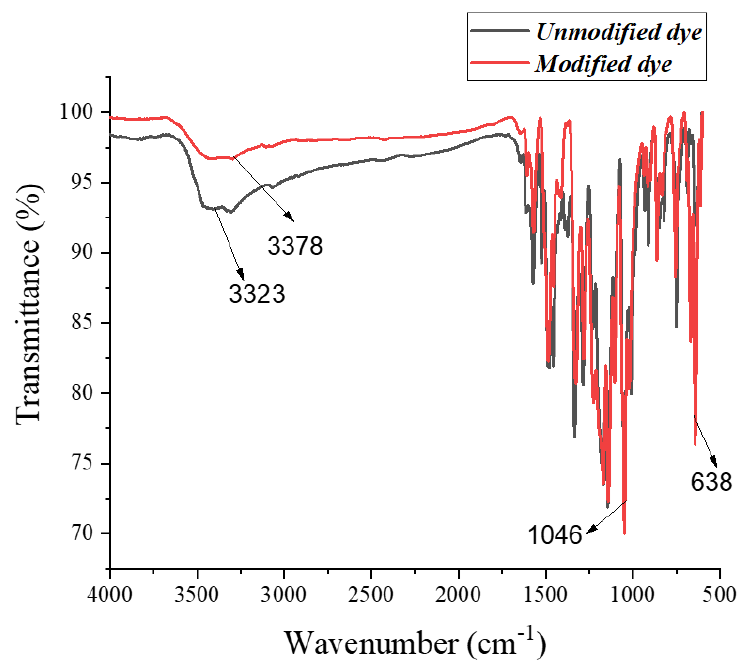
Figure 6. IR spectra of modified and unmodified dye .